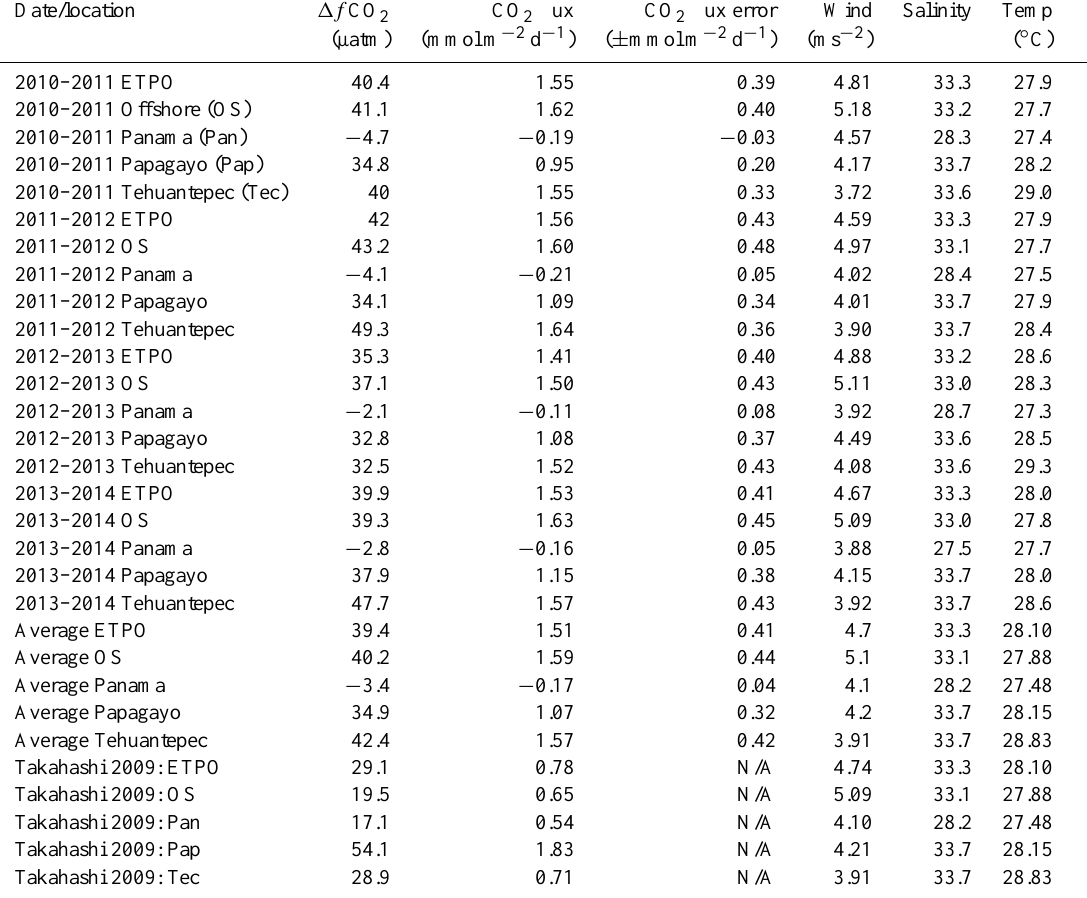
Table A1. Annual averaged values for each region, as reported in Fig. 8, and average values from Takahashi et al.